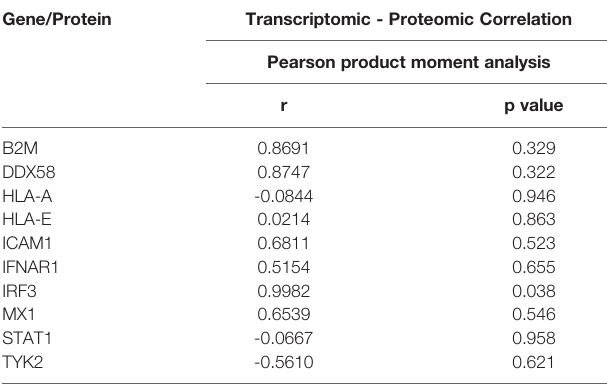
TABLE 1 | Pearson ’ s product moment correlation coef fi cient of IFN pathway- related genes. Gene/Protein Transcriptomic - Proteomic Correlation Pearson product moment